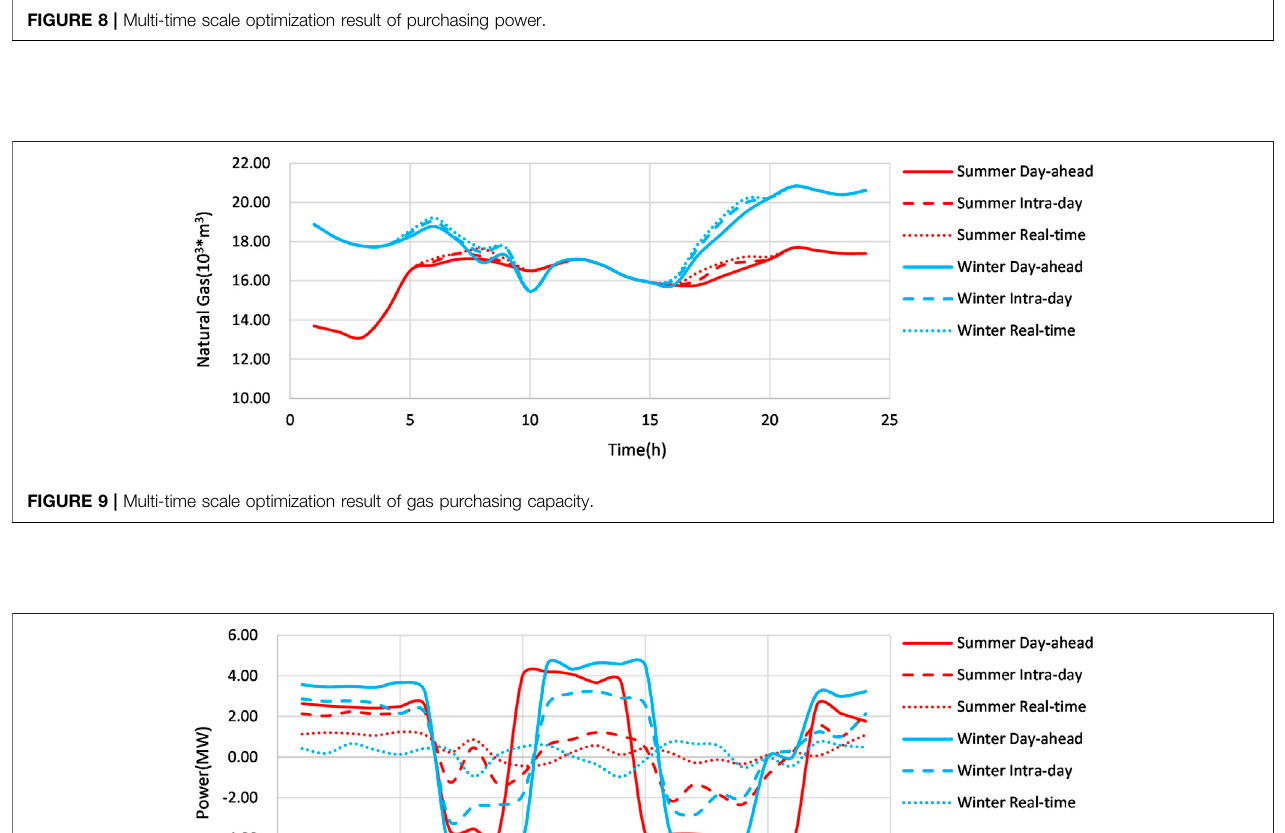
FIGURE 8 | Multi-time scale optimization result of purchasing power.